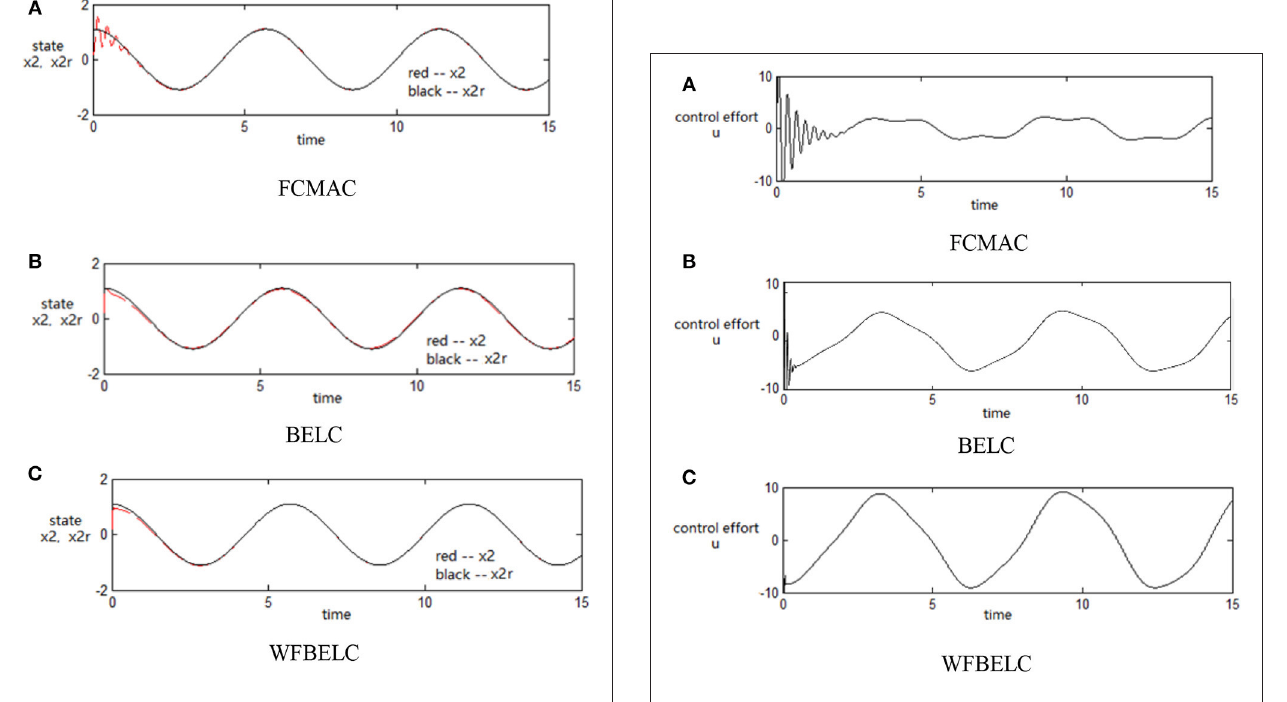
FIGURE 11 | Response tracking curves of state x 2 ( q = 8) (A) FCMAC, (B) BELC, and (C) WFBELC.